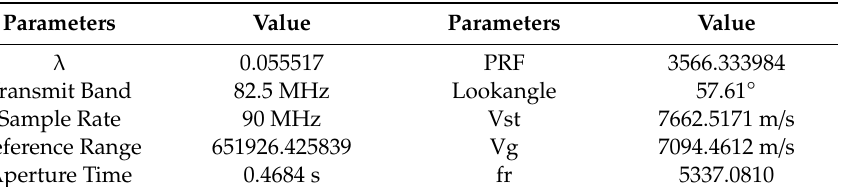
Table 5. GF-3 radar parameters.